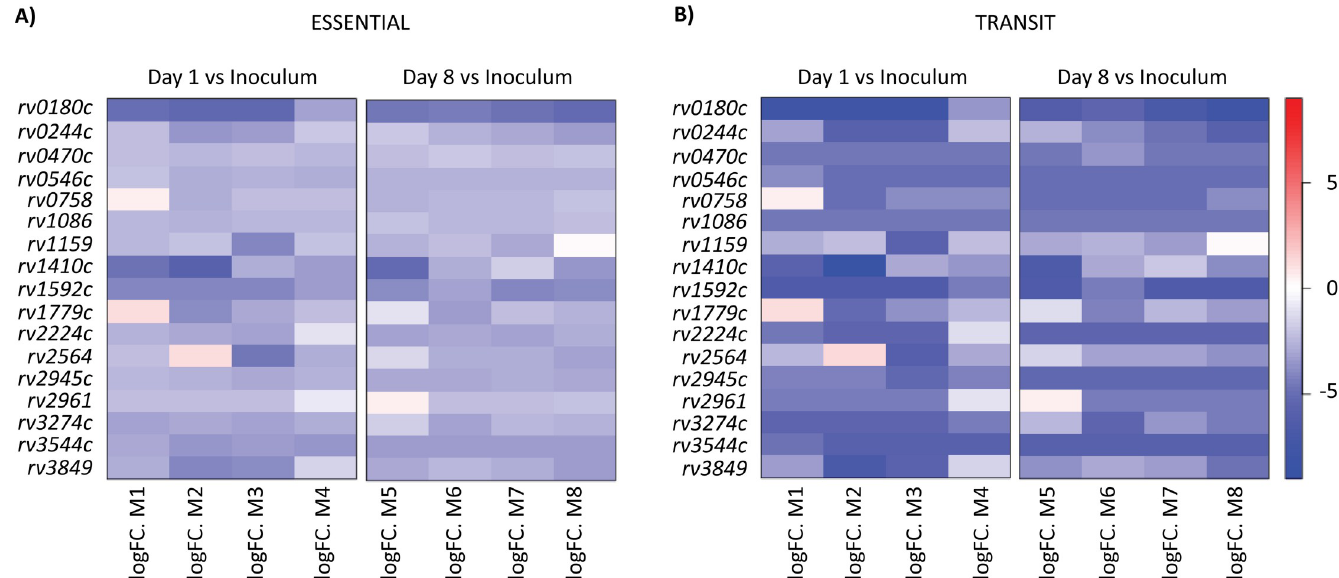
Fig 2. Heat-map for the number of reads in the selected genes after 1 or 8 days of infection for each mouse in comparison to the inoculum. The 17 selected genes were identified using both ESSENTIAL and TRANSIT softwares. The color scale corresponds to the log fold change of the number of reads.